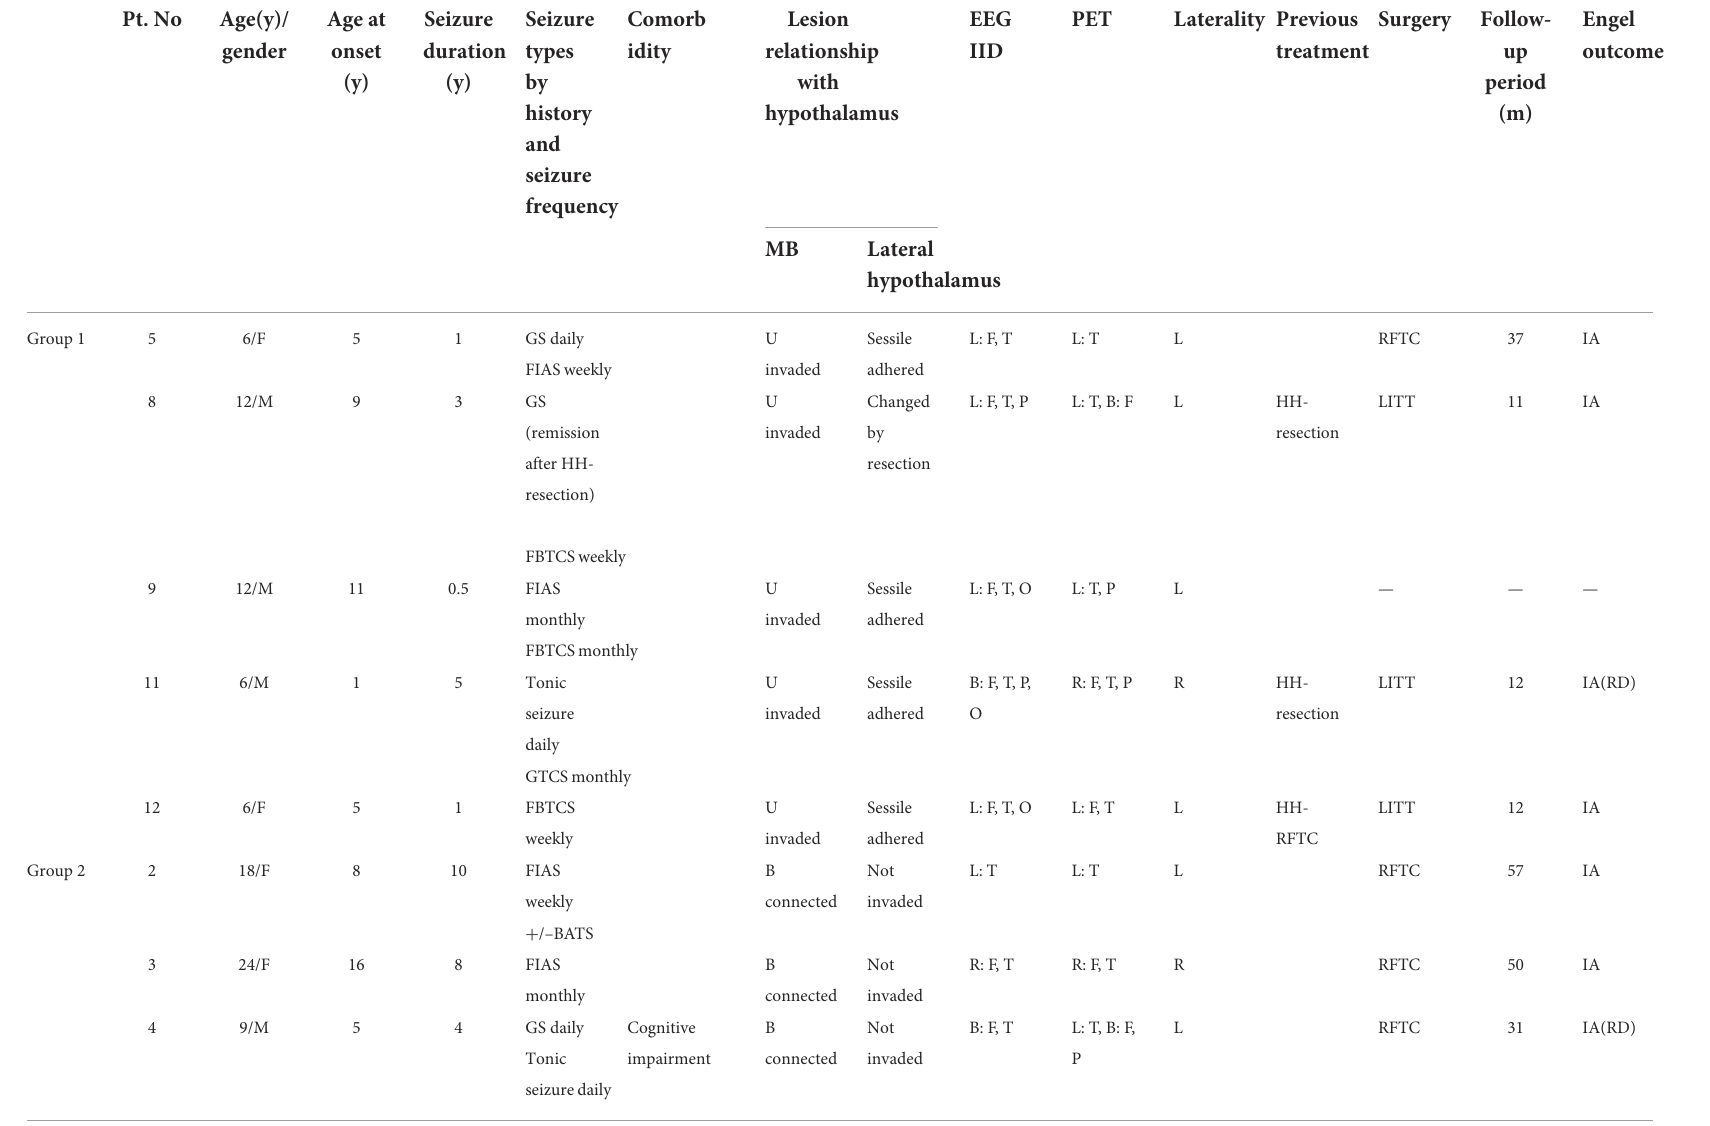
TABLE 1 Patient demographics, preoperative work-up, and